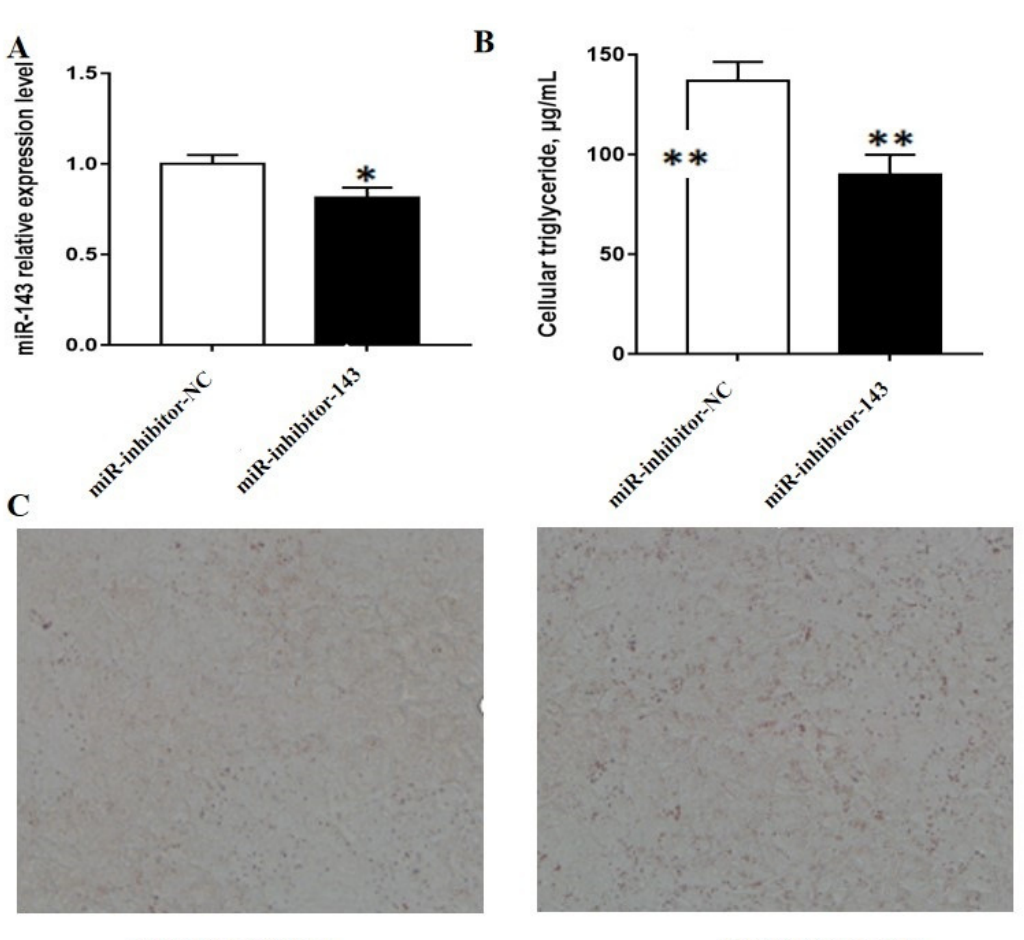
Figure 2. E ff ects of miR-143 inhibitor on milk fat synthesis. ( A ) miR-143 expression following miR-143 inhibitor treatment; ( B ) triglyceride levels in BMECs after treatment with the miR-143 inhibitor; ( C ) alterations in the number of lipid droplet in BMECs after miR-143 inhibitor treatment * p < 0.05; ** p < 0.01.